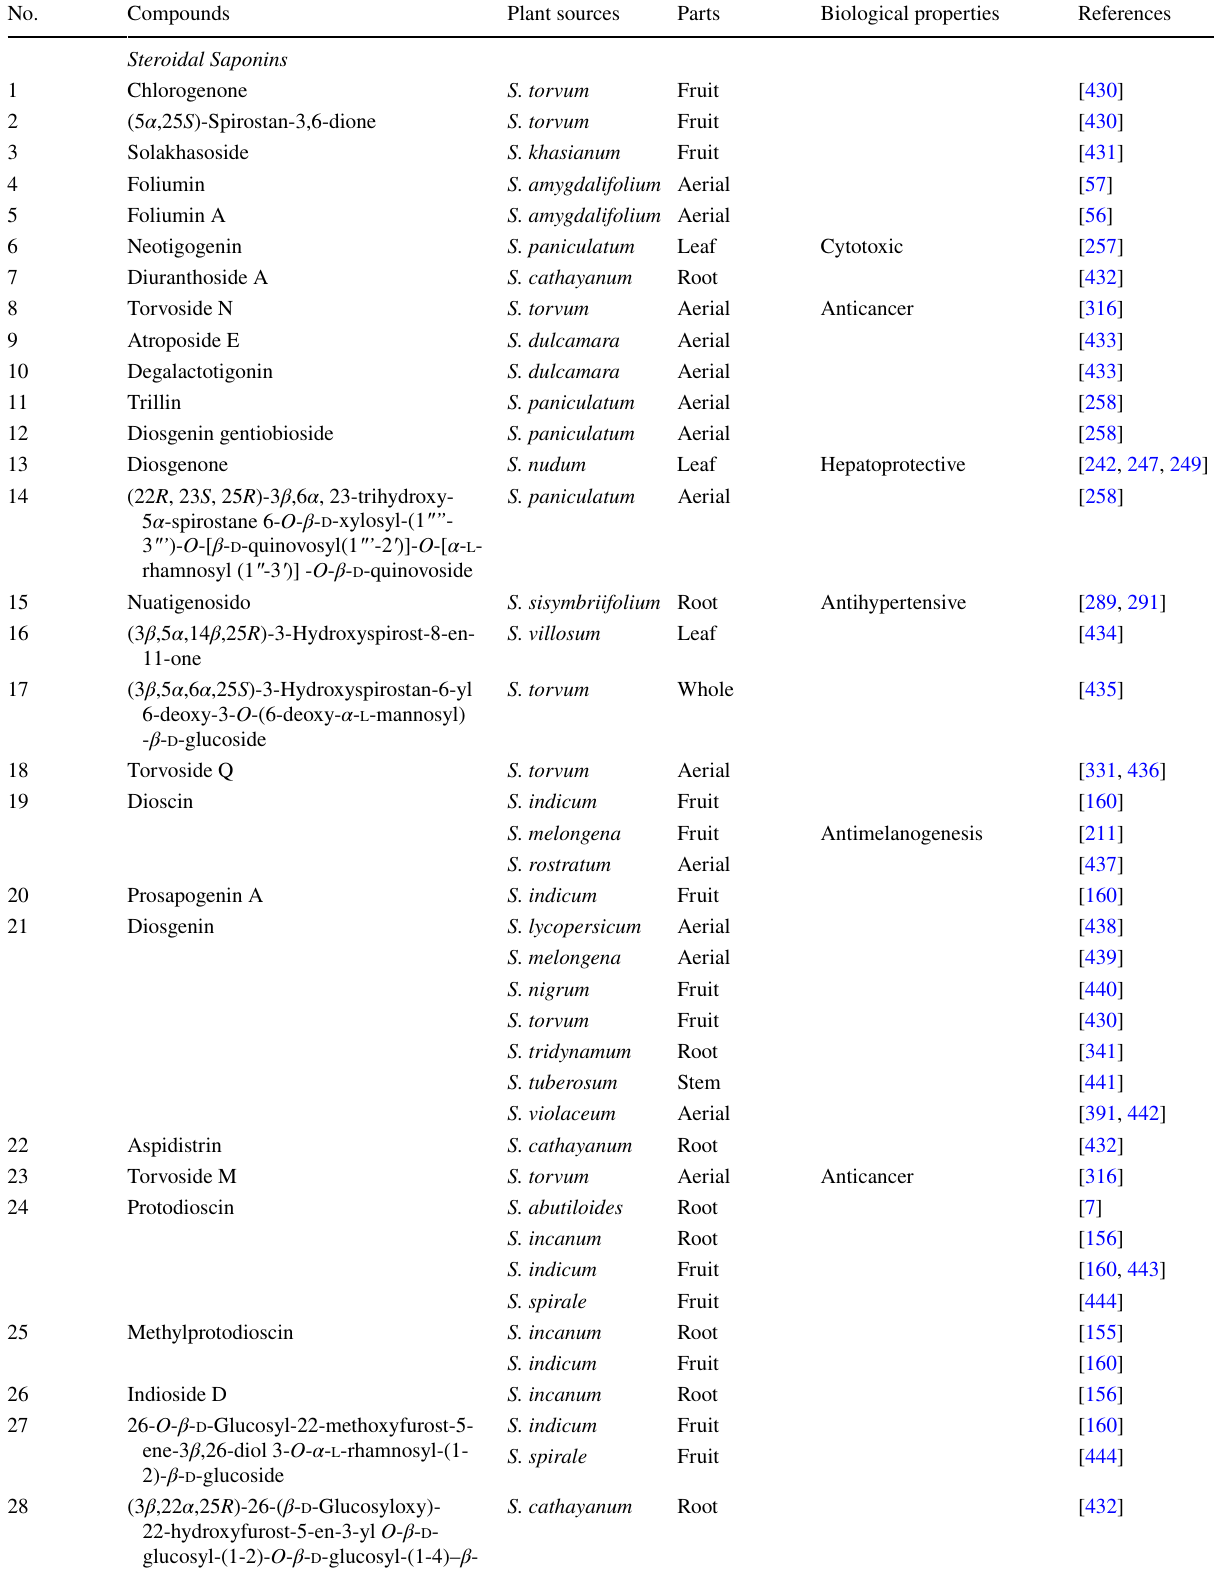
Table 2 Phytochemistry, biological properties and classification of Solanum compounds No.